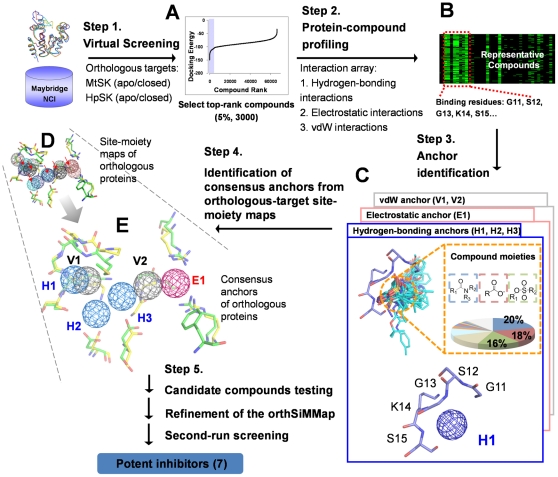
Framework of CoreSiMMap-based screening method.In Step 1, GEMDOCK was used to generate docked poses for HpSK and MtSK by screening compound libraries (Maybridge and NCI). For each target (HpSK or MtSK), the protein-compound interacting profile was derived by the top 2% (∼6,000) of compounds ranked by docking energy. In Step 3, conserved interactions of the target protein and chemical moieties of ligands are identified to deduce the anchors of HpSK and MtSK. The CoreSiMMap is constructed based on the features that are conserved between orthologous target site-moiety maps, which will be used to select candidate compounds for the enzymatic assay. Finally, the model is refined based on the bioassay of candidate compounds.